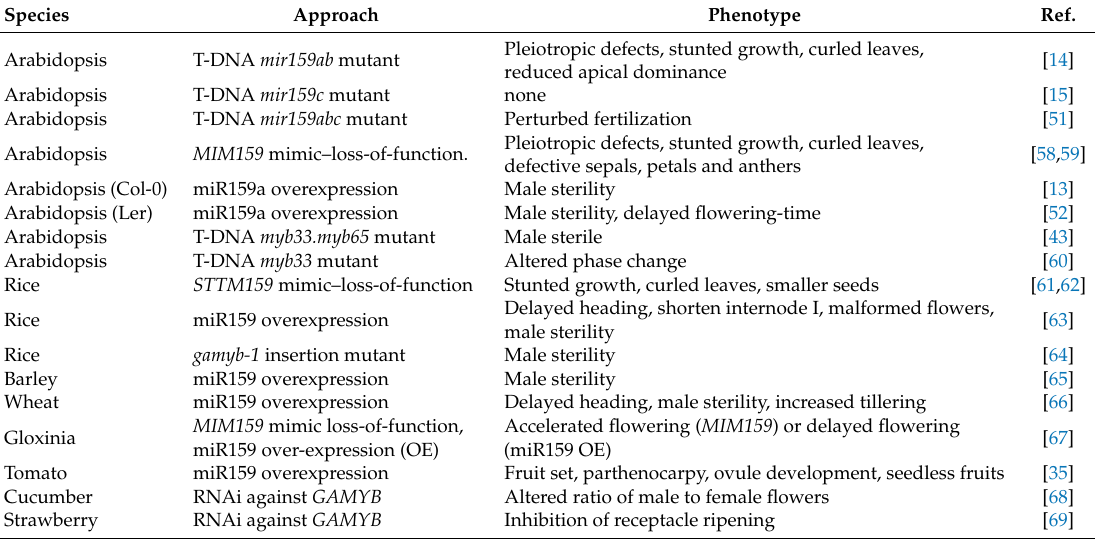
Table 2. Functional analyses of the miR159- GAMYB pathway in